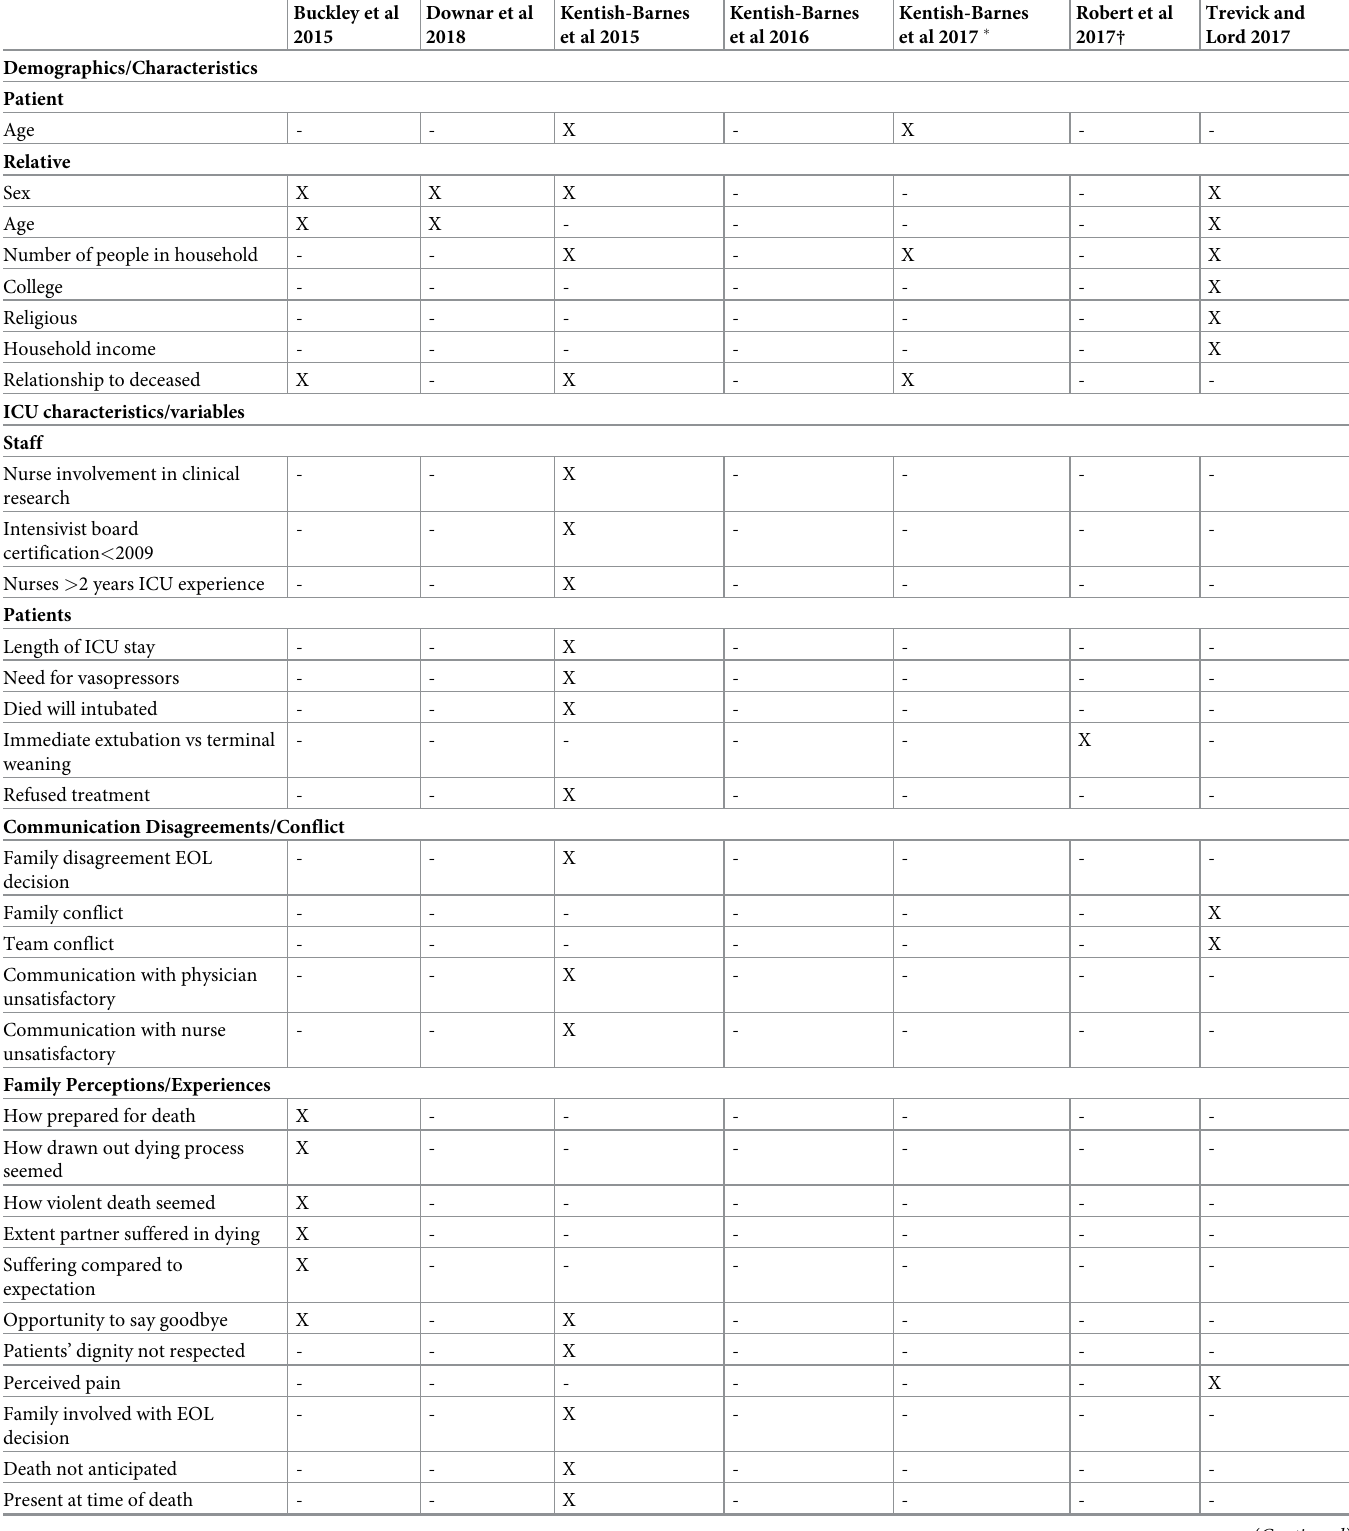
Table 3. Table indicating the risk factors each of the papers investigated and when each risk factor was